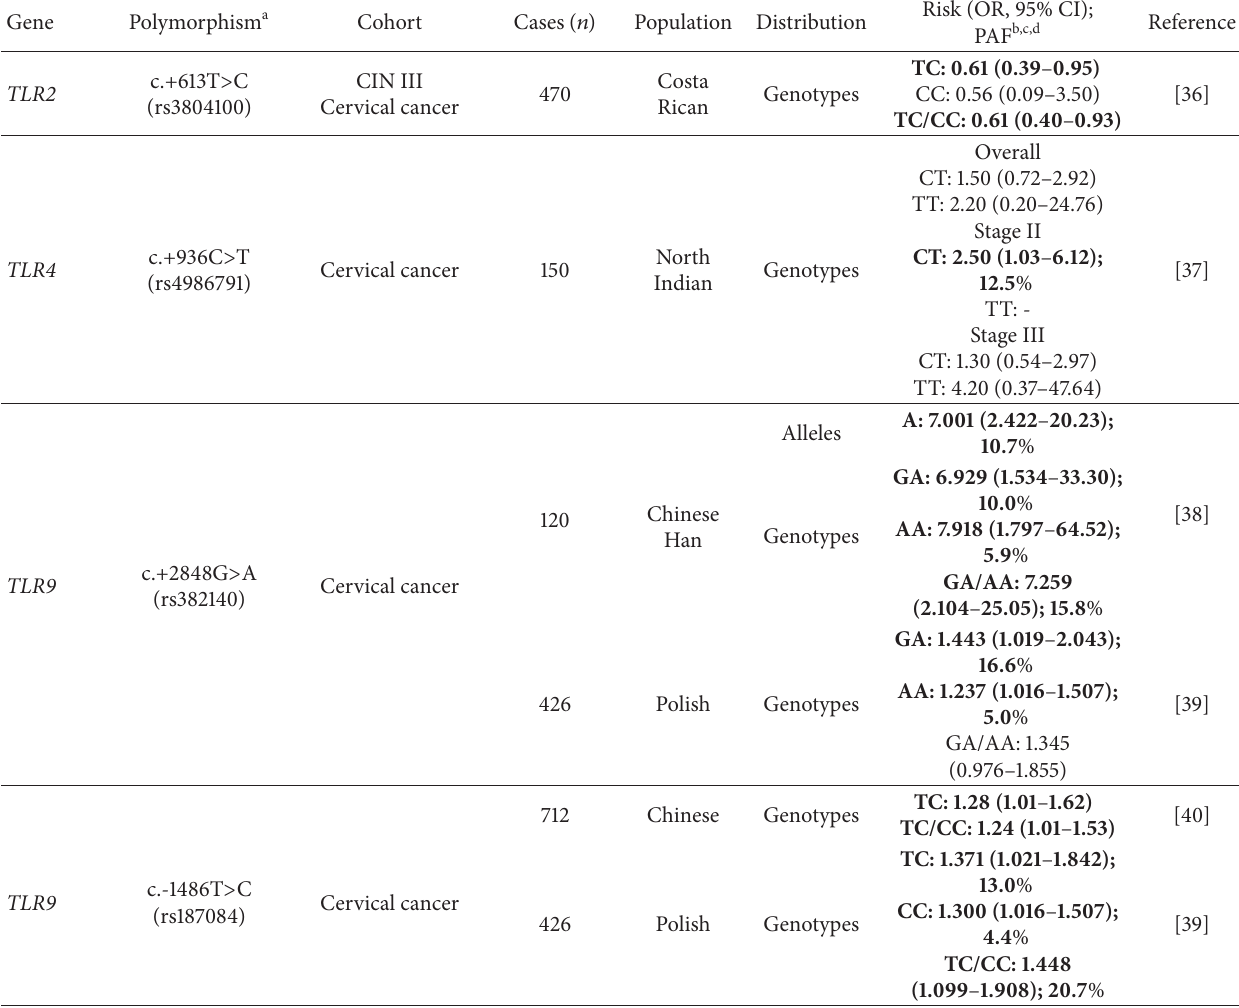
Table 5: Overview of polymorphisms in toll-like receptor genes encoding receptors and association with cervical neoplasia risk. Gene Polymorphism